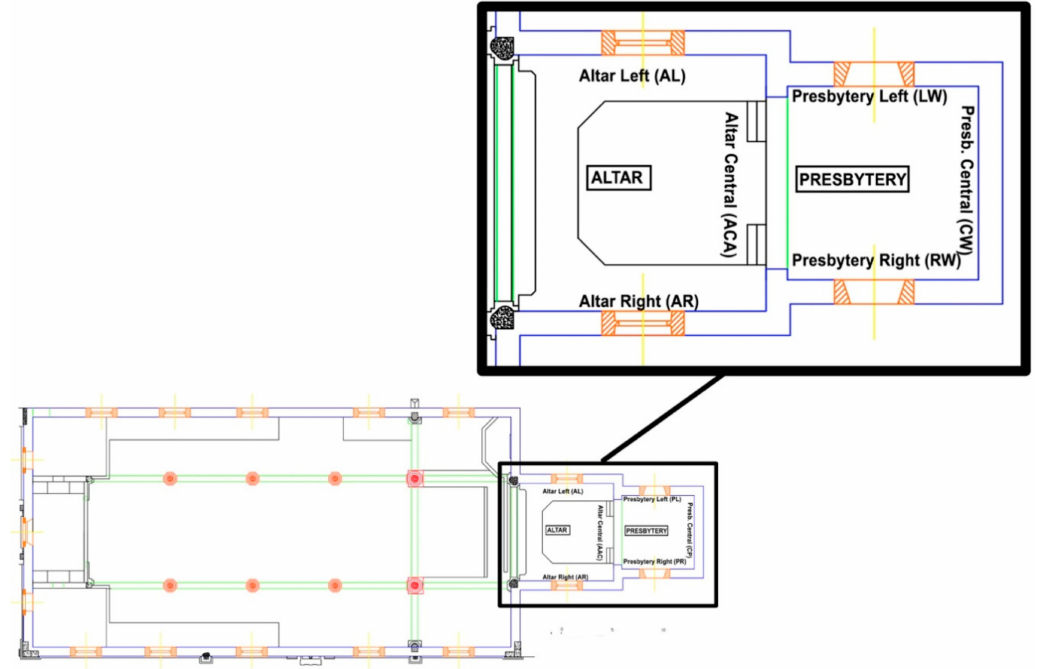
Figure 3. Planimetric map of St Augustine church.